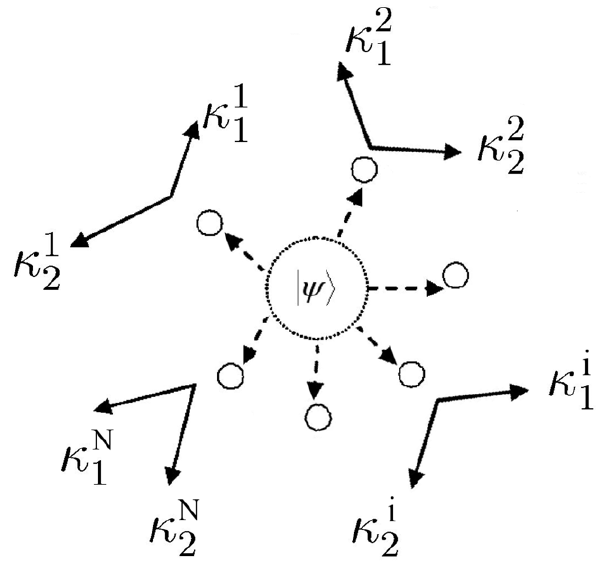
Figure 1. The EPR setup for an N -player quantum game. In this setup, each player i has a choice of two measurement directions k i for their qubit, allocated from a shared N -qubit quantum state. k i 2